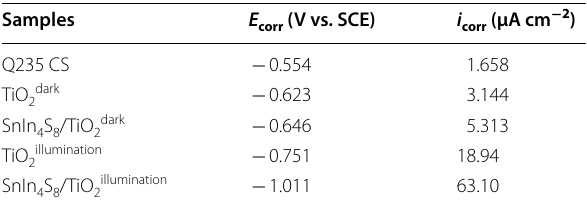
Table 1 Electrochemical parameters obtained by the Tafel curves of Q235 CS, TiO in the dark, TiO under illumination